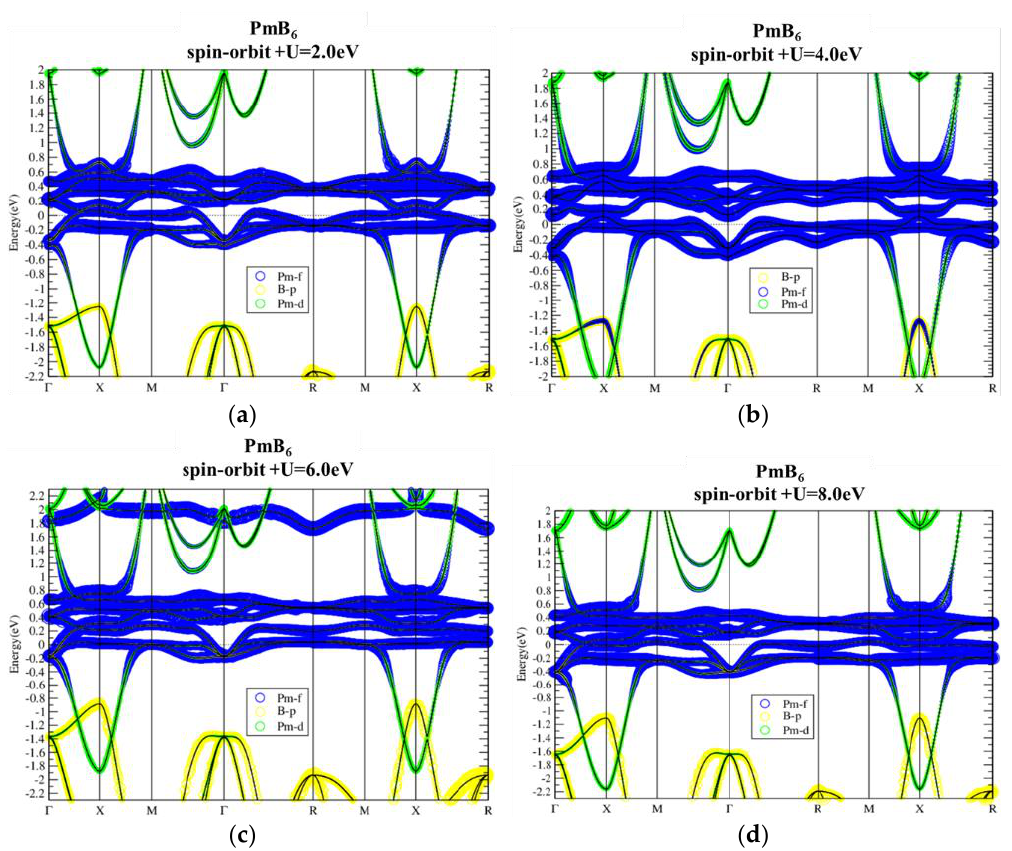
Figure 11. Band structures of PmB 6 with SOI and U = 2, 4, 6, 8 eV ( a–d , respectively). As U is tuned larger, the highest f band is lifted but the band property is not changed near the Fermi level.